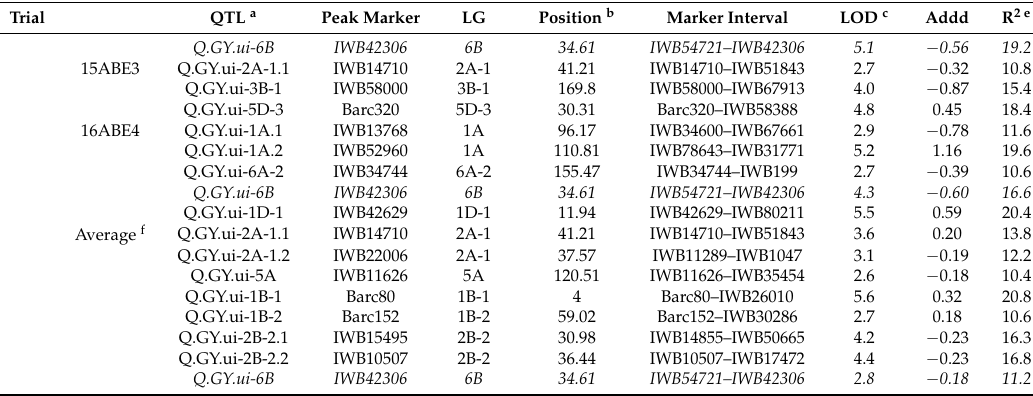
Table 7. QTLs for plant height (PH), thousand kernels weight (TKW) and grain yield (GY) detected in the DH population of UI Platinum/SY